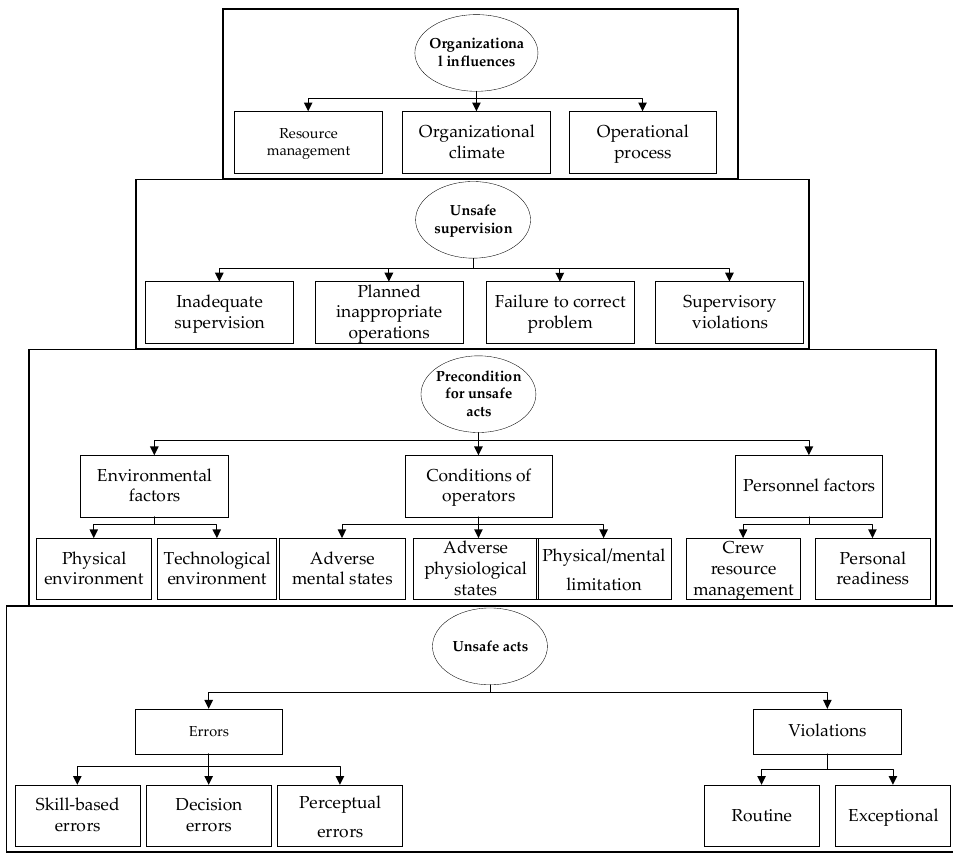
Figure 1. Traditional HFACS structure.